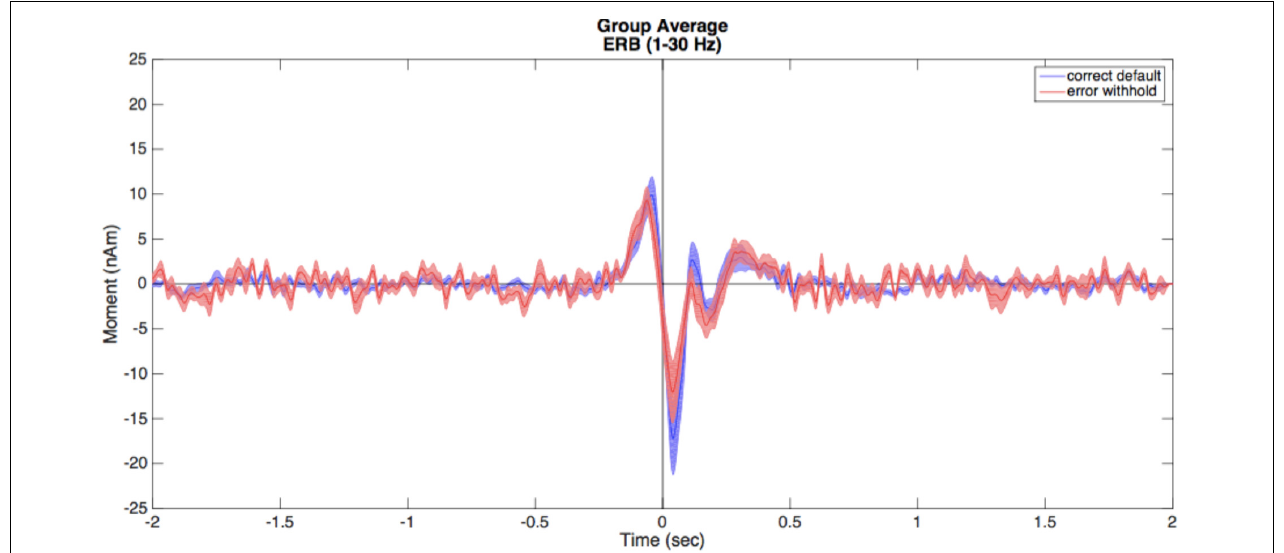
FIGURE 5 | Virtual sensors (VS). Illustrated here are the averaged VS plots calculated from the ERB peak of each condition. Correct default (in blue) and error withhold (in red) plots are displayed with shaded standard error bars using BrainWave tools, then edited to a single plot using Matlab’s figure editing tools (e.g., overlay, add legend, text size,